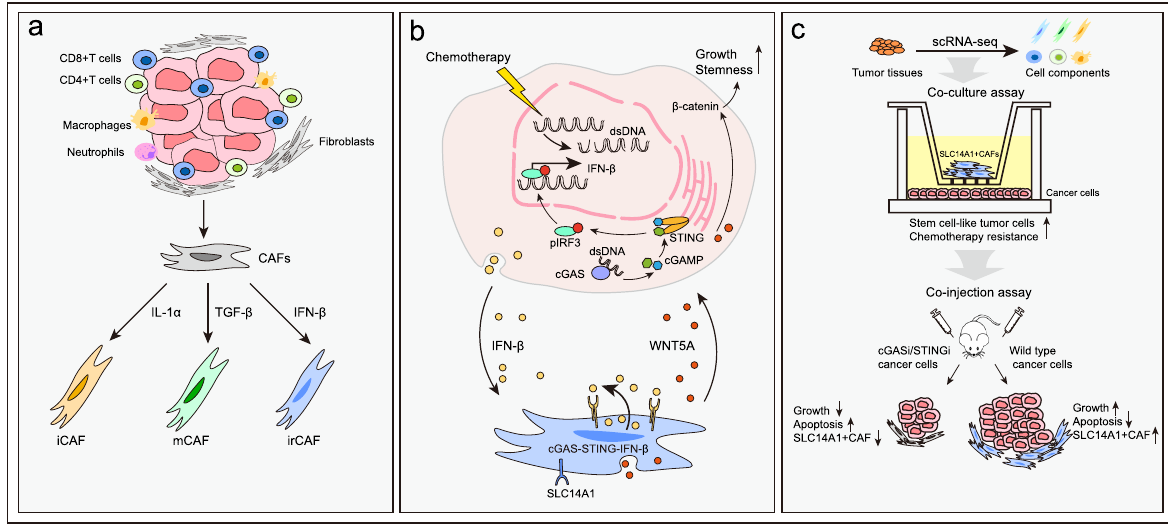
Fig. 1 Mechanisms for irCAF evolution and their cancer stemness-promoting function. a Different cytokines induce CAF differentiation into distinct subtypes. b The regulatory loop between cancer cells and irCAFs. Cancer cells secret IFN-β to promote irCAF formation, while irCAFs generate WNT5A to enhance cancer stemness. c The brief exploration schematic diagram of the work. irCAFs are identified in bladder cancer tissues by scRNA-seq. The ex vivo and in vivo experiments validate the cancer-promoting effects of